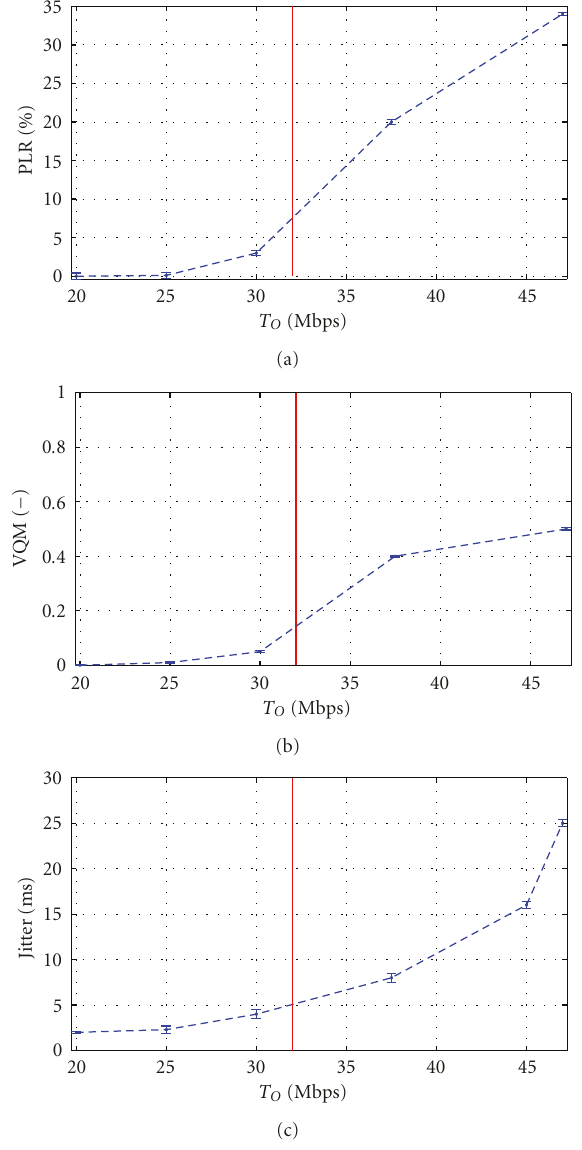
Figure 5: Unicast video streaming, additional data tra ffi c, and no interference: (a) PLR, (b) VQM, and (c) jitter versus the overall network load, T O